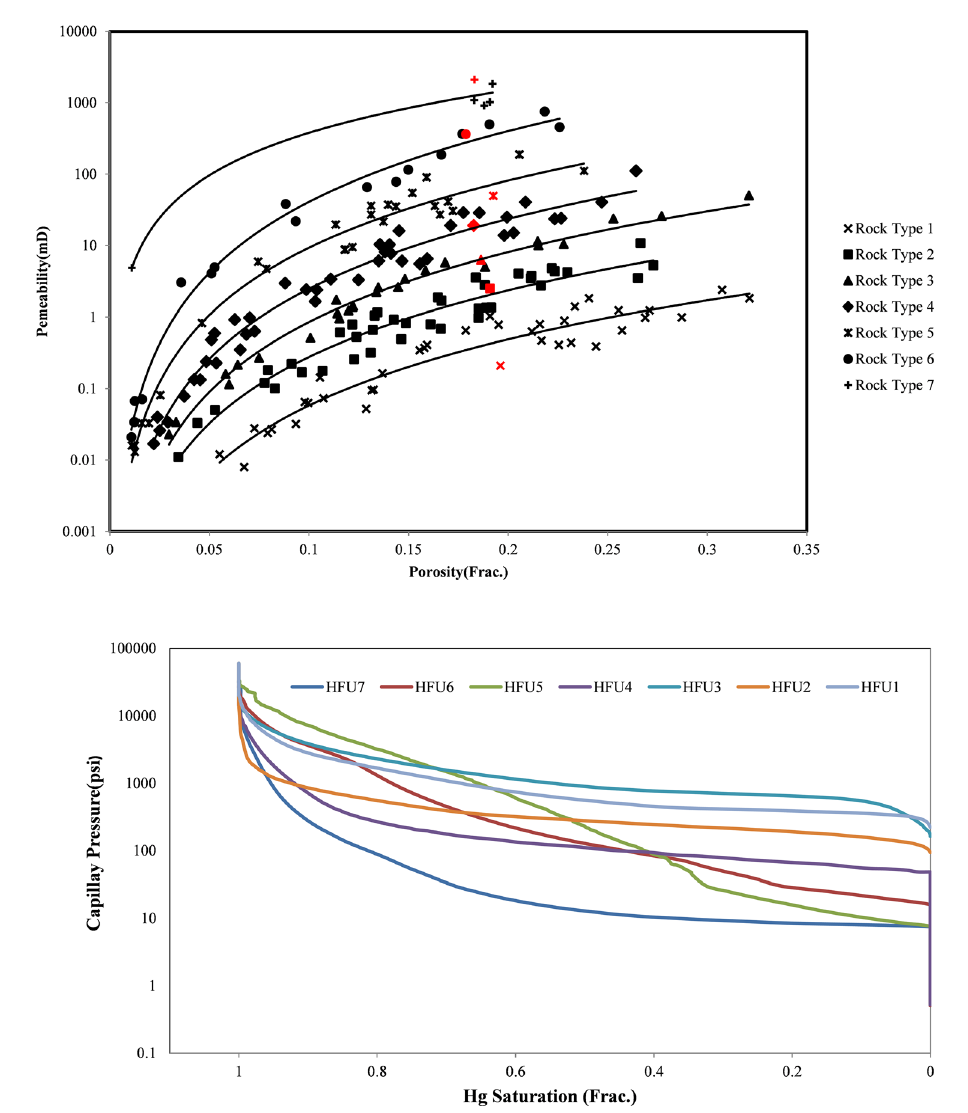
Fig. 4 The plot of the logarithm of sample air permeability ver- sus sample porosity for different rock types